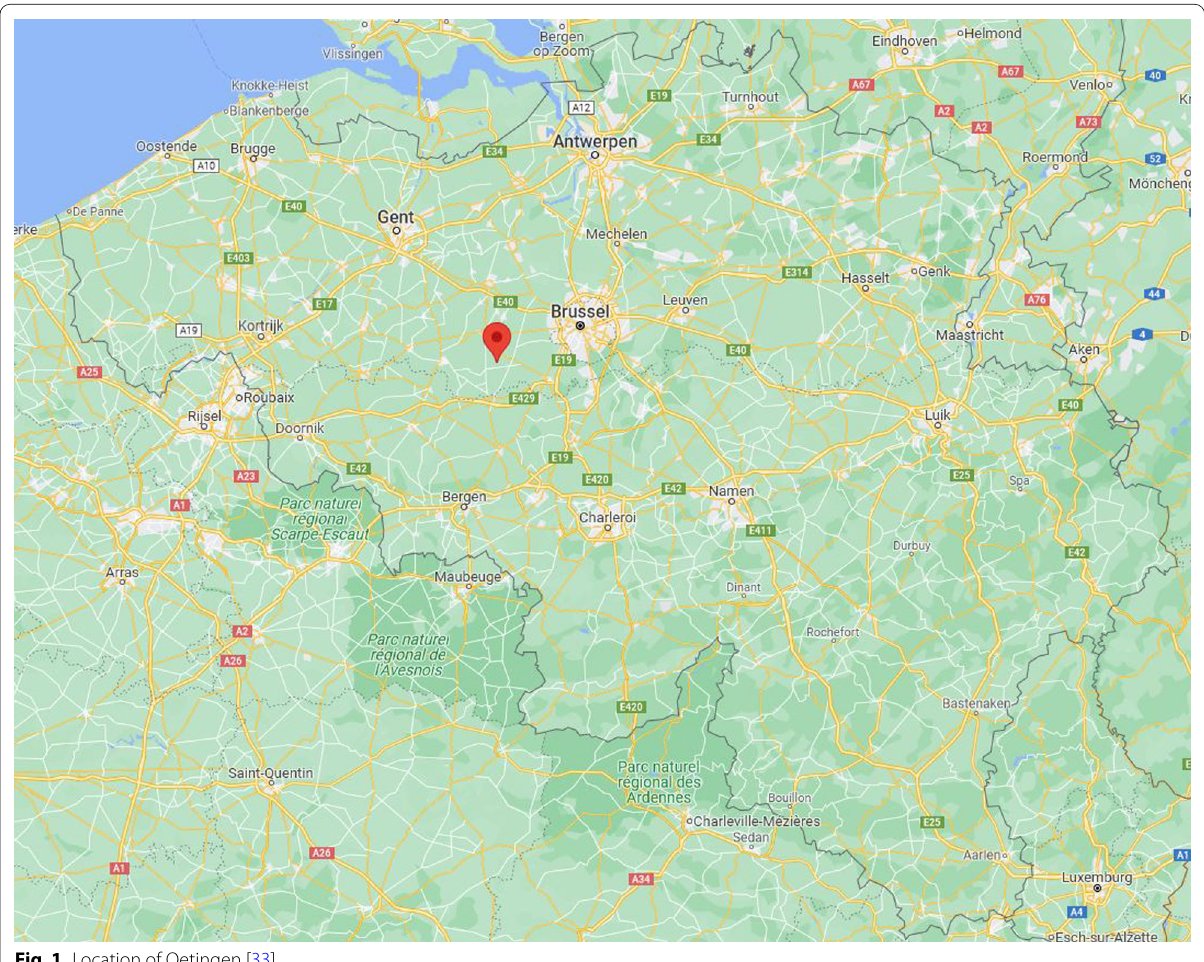
Fig. 1 Location of Oetingen